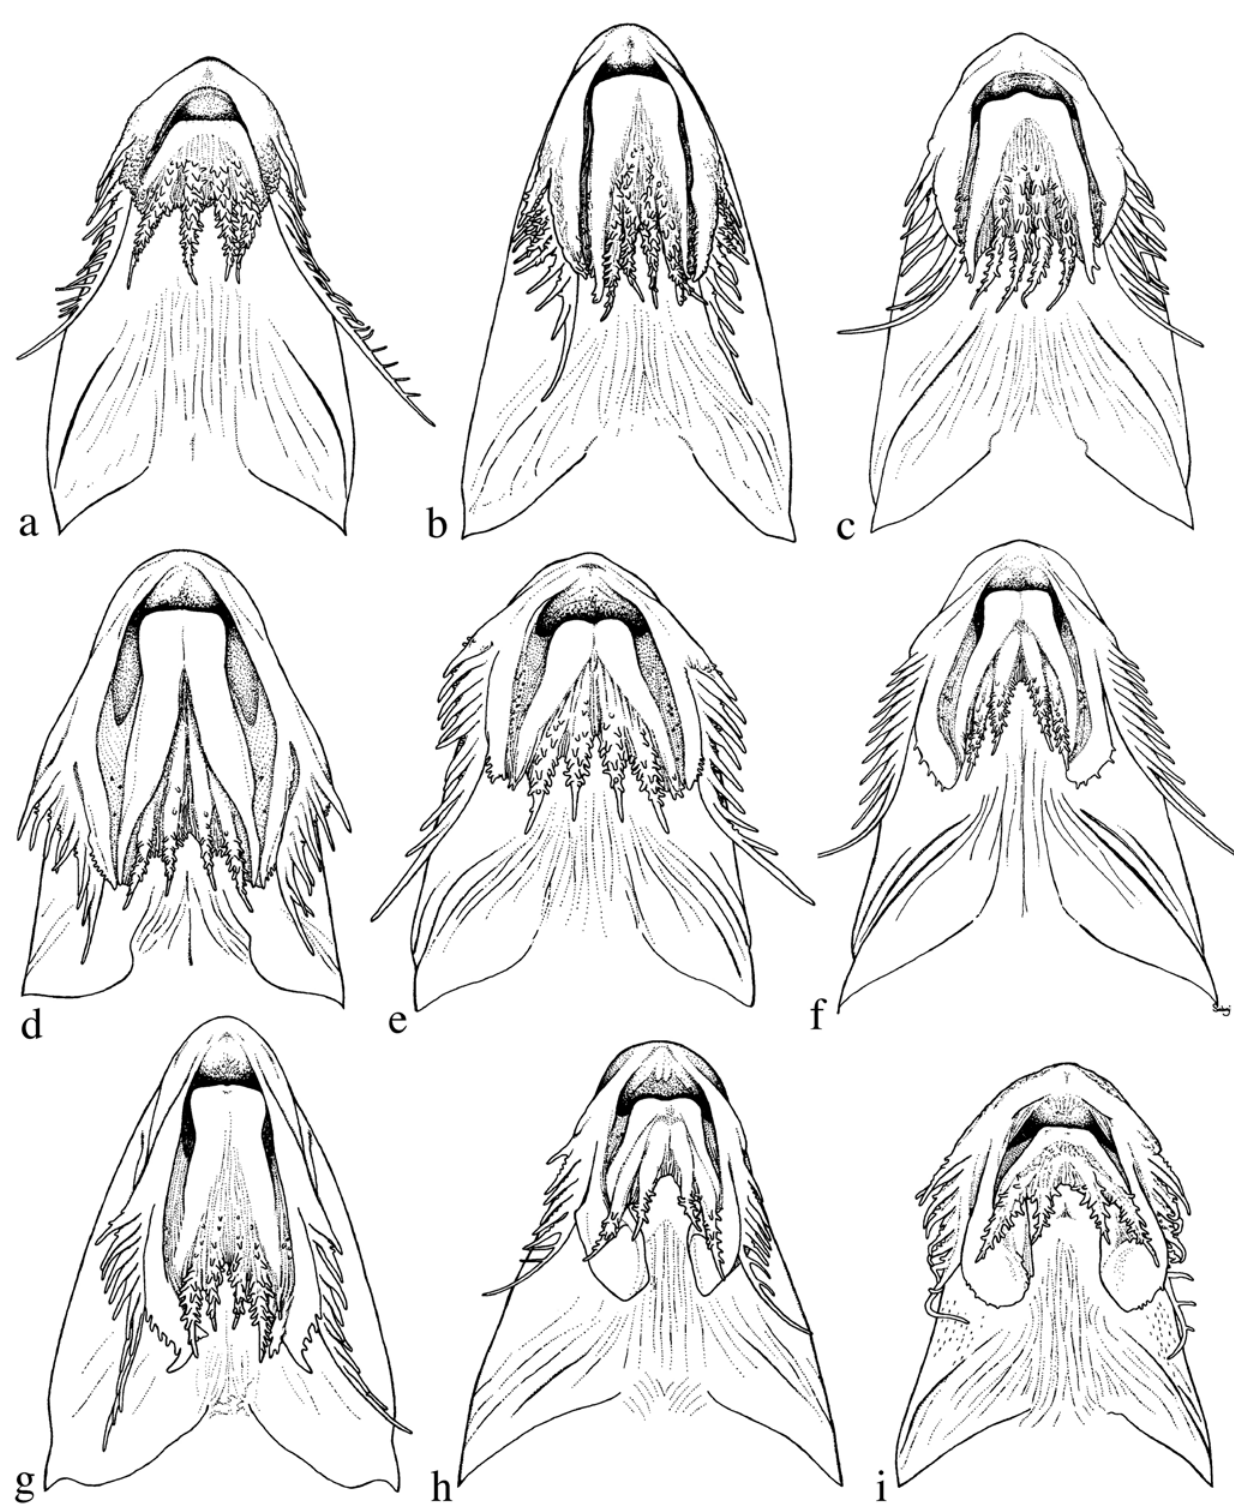
Fig. 4. Variation in oral-hood morphology in Anduzedoras and Leptodoras . a. A. oxyrhynchus , ANSP 160628 (SL 124.6 mm). b. L. praelongus , ANSP 162464 (SL 124.9 mm). c. L. copei , ANSP 162461 (SL 95.9 mm). d. L. hasemani , ANSP 175889 (SL 86.7 mm). e. L. linnelli , ANSP 175883 (SL 94 mm). f. L. nelsoni , MCNG 13167 (SL 93 mm). g. L. cataniai , ANSP 161533 (SL 162.5 mm). h. L. juruensis , INHS 39465 (SL 117.4 mm). i. L. myersi , ANSP 112319 (SL 72.6